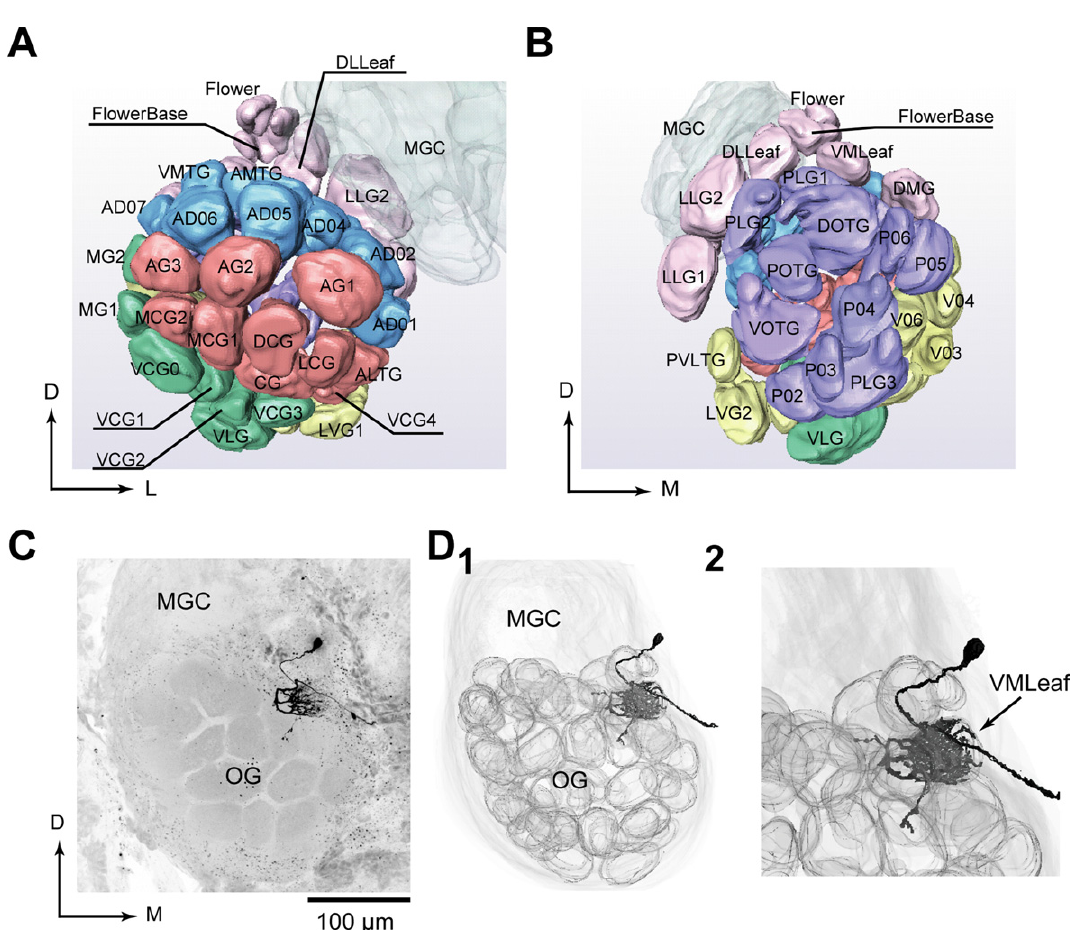
Figure 1 | Morphological atlas of olfactory glomeruli . (A) Anterior view of the digital atlas of the AL. Names of glomeruli are shown. (B) Posterior view of the atlas. (C) Confocal image of a uniglomerular projection neuron (PN) with dendritic arborizations confi ned to the dorsomedially-located glomerulus, VMLeaf. This PN innervated the entire region of a glomerulus and ran through the inner antenno-cerebral tract. Two additional branches innervating outside the glomerulus were observed. Its soma was located in the medial cell cluster. (D1) Three-dimensional reconstruction of the same neuron with glomerular structure. (D2) Higher magnifi cation of (D1) . D, dorsal; M, medial; MGC, macroglomerular complex; L, lateral; OG, ordinary